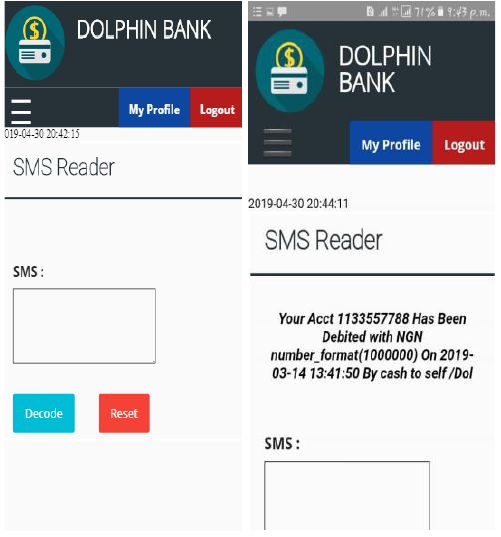
Fig. 12. SMS Encoder and